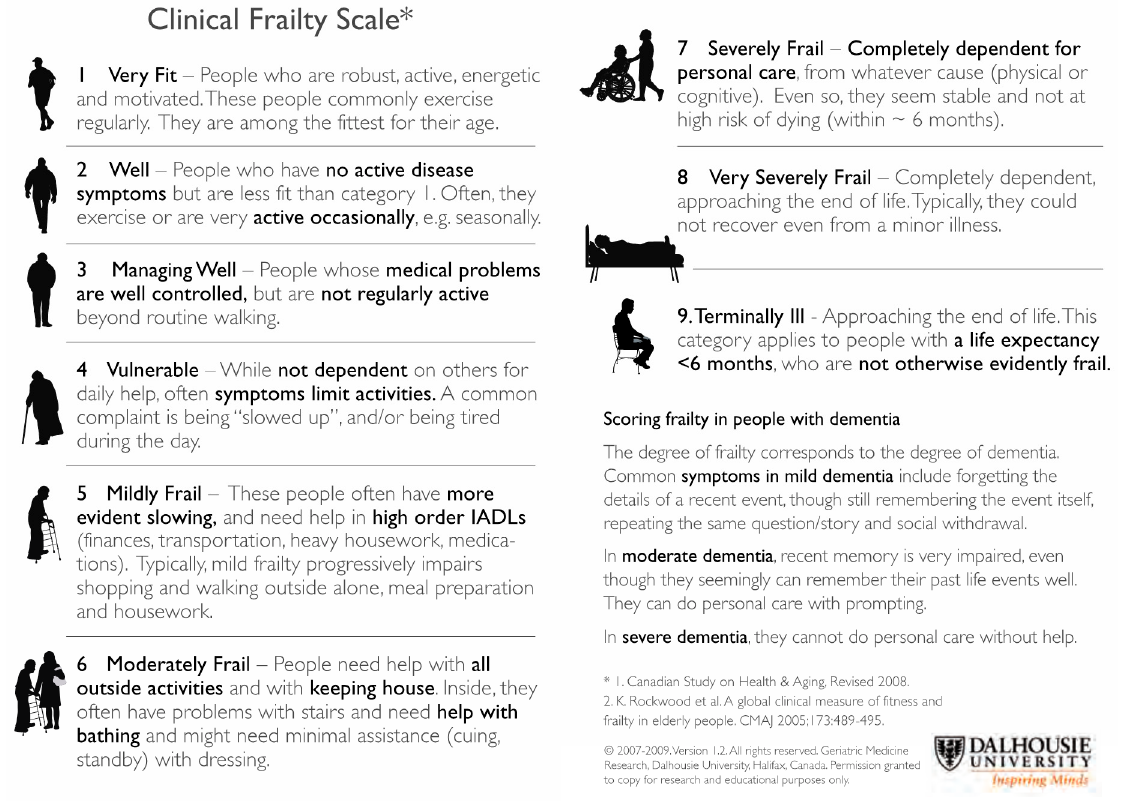
Figure 1. The Clinical Frailty Scale (CFS) [5].